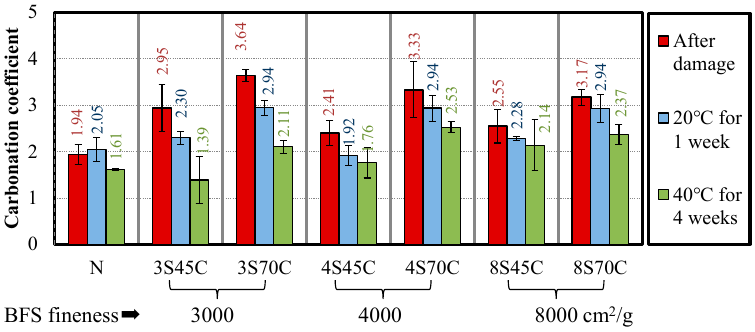
Figure 12. Carbonation coe ffi cients of the mortar samples after damage and after water curing.